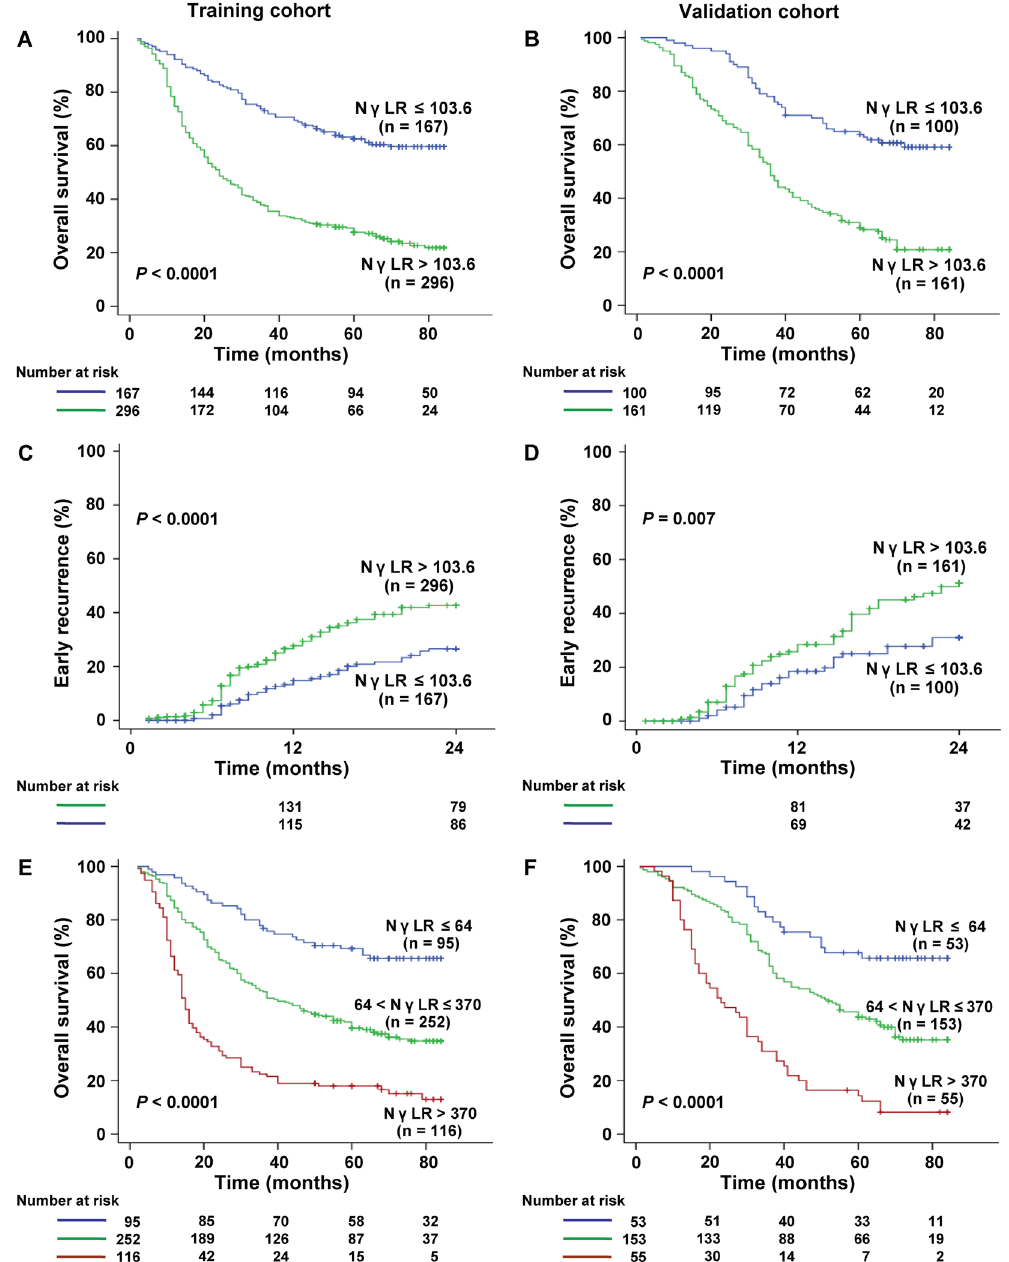
Figure 3. Prognostic significance of N γ LR in patients with HCC after surgery. The Kaplan-Meier curves depict overall survival ( A,B ) and recurrence rates ( C,D ) in HCC patients with N γ LR > 103.6 or ≤ 103.6 and estimate the overall survival according to the optimized N γ LR (E-F) in the training and validation